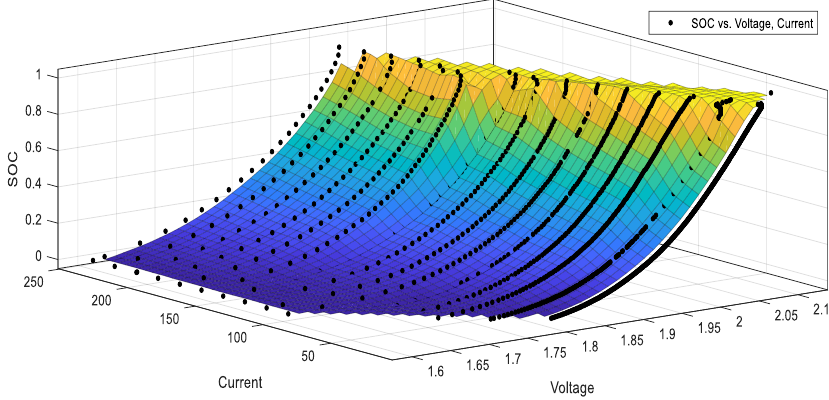
Figure 10. Fitting curve of voltage, current, and SOC.